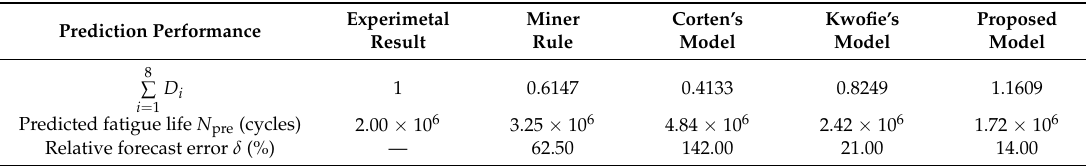
Table 6. Prediction performances of Miner rule, Corten’s model, Kwofie’s model, and the proposed model for CFD1